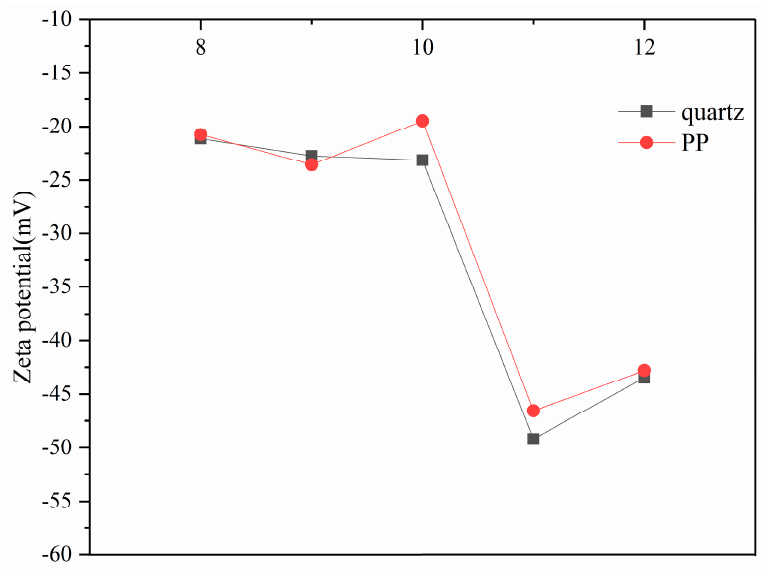
Figure 4. Evolution of the zeta potential of PP and quartz particles as a function of pH in NaOH solution.